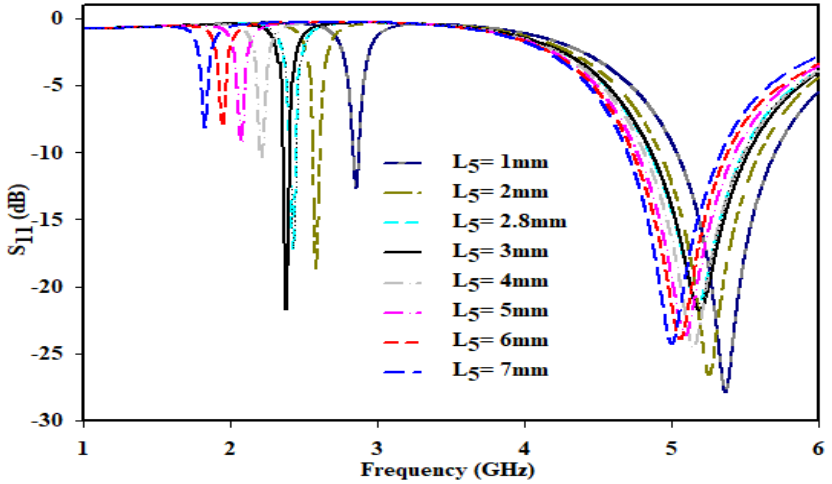
Figure 10. Variation in resonant frequency with respect to slot length.